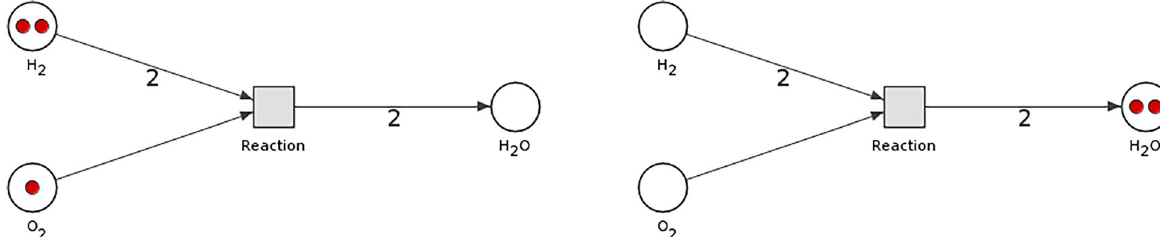
Figure 1. This example of simple Petri net-based model, shows a binding reaction of two hydrogen molecules and one oxygen molecule into one molecule of water (H 2 O). The left image shows state before binding and the right one after. Red tokens were consumed from a proper places and new one corresponding to a new molecule has been